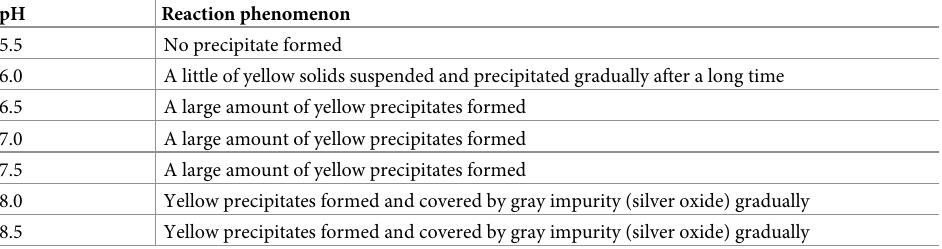
Table 3. Reaction phenomena in forming silver phosphate at different pH levels by rapid